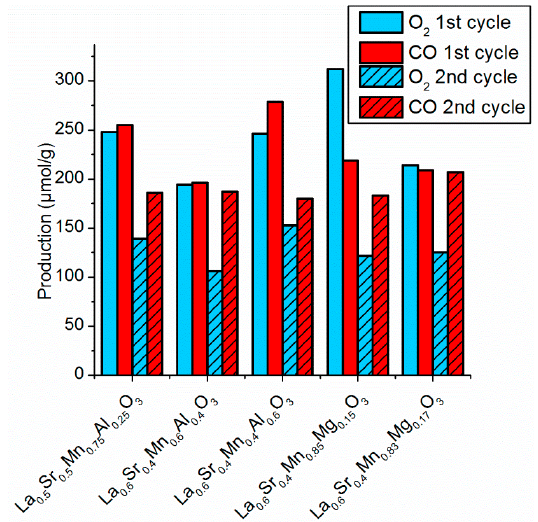
Figure 6. Comparison of O 2 and CO production for La 1 − x Sr x Mn 1 − y Al y O 3 and La 1 − x Sr x Mn 1 − y Mg y O 3 perovskite series (T red = 1400 °C and T ox = 1050 °C) [41].